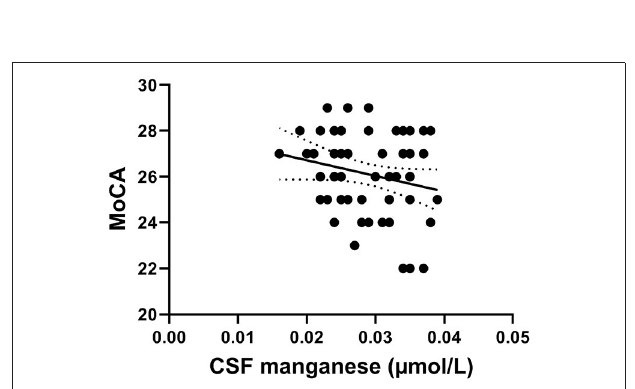
FIGURE 2 | The negative correlation of manganese levels with MoCA scores in young smokers ( r = − 0.349, p =